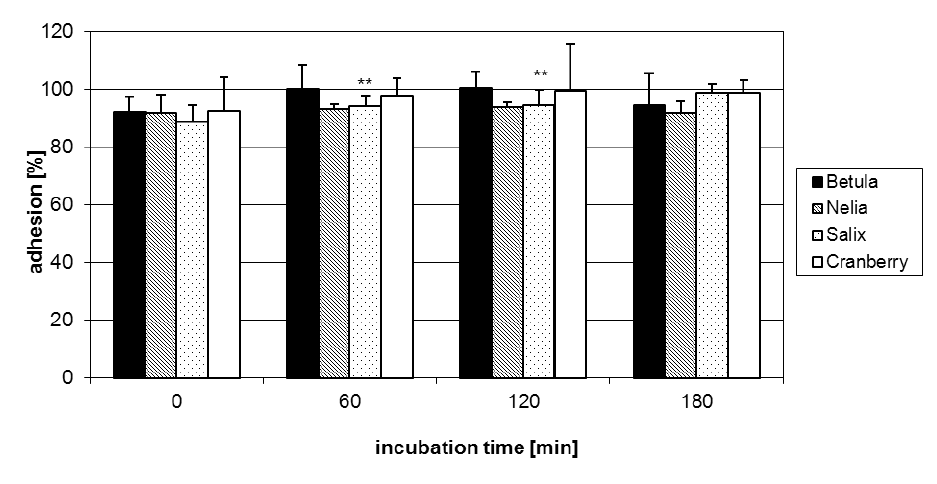
Figure 5. Adhesion of GAS pre-treated with purified A- and B-type procyanidin samples to human HEp-2 cells as assessed by FACS analysis. Data represent the mean ± SD of epithelial cells that showed fluorescent bacteria and are derived from at least three independent experiments (* p <